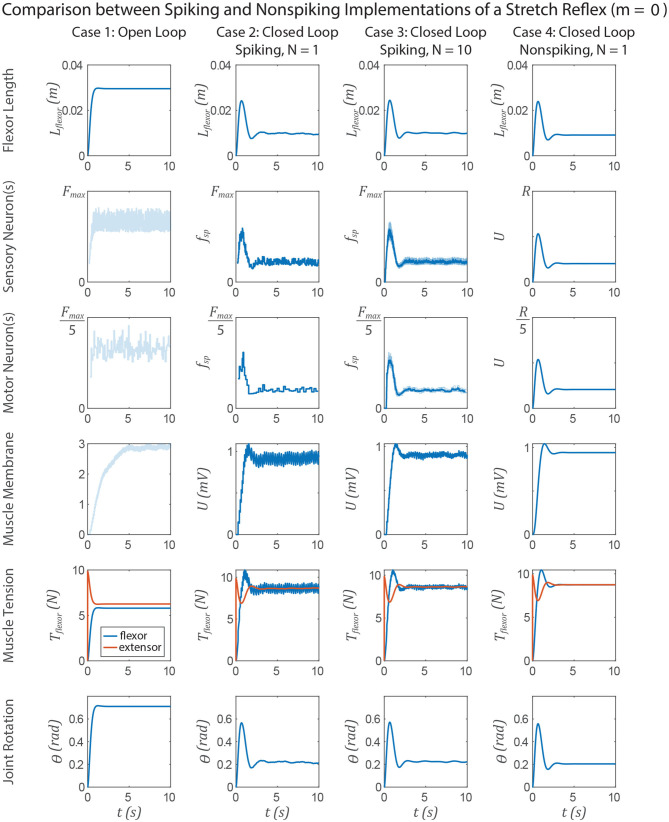
Data from a simulation of the system in Figure 1. Each column shows data from a different configuration of the system, from left to right: Case 1, open loop; case 2, spiking reflex pathway, N = 1; case 3, spiking reflex pathway, N = 10 (fsp for every neuron is shown in light blue, population mean fsp is plotted in dark blue); case 4, non-spiking reflex pathway. All corresponding axes are scaled the same. Each row plots data from a different stage of the reflex loop as depicted in Figure 1. In this figure, all spiking neurons have a constant spiking threshold θ (i.e., m = 0).